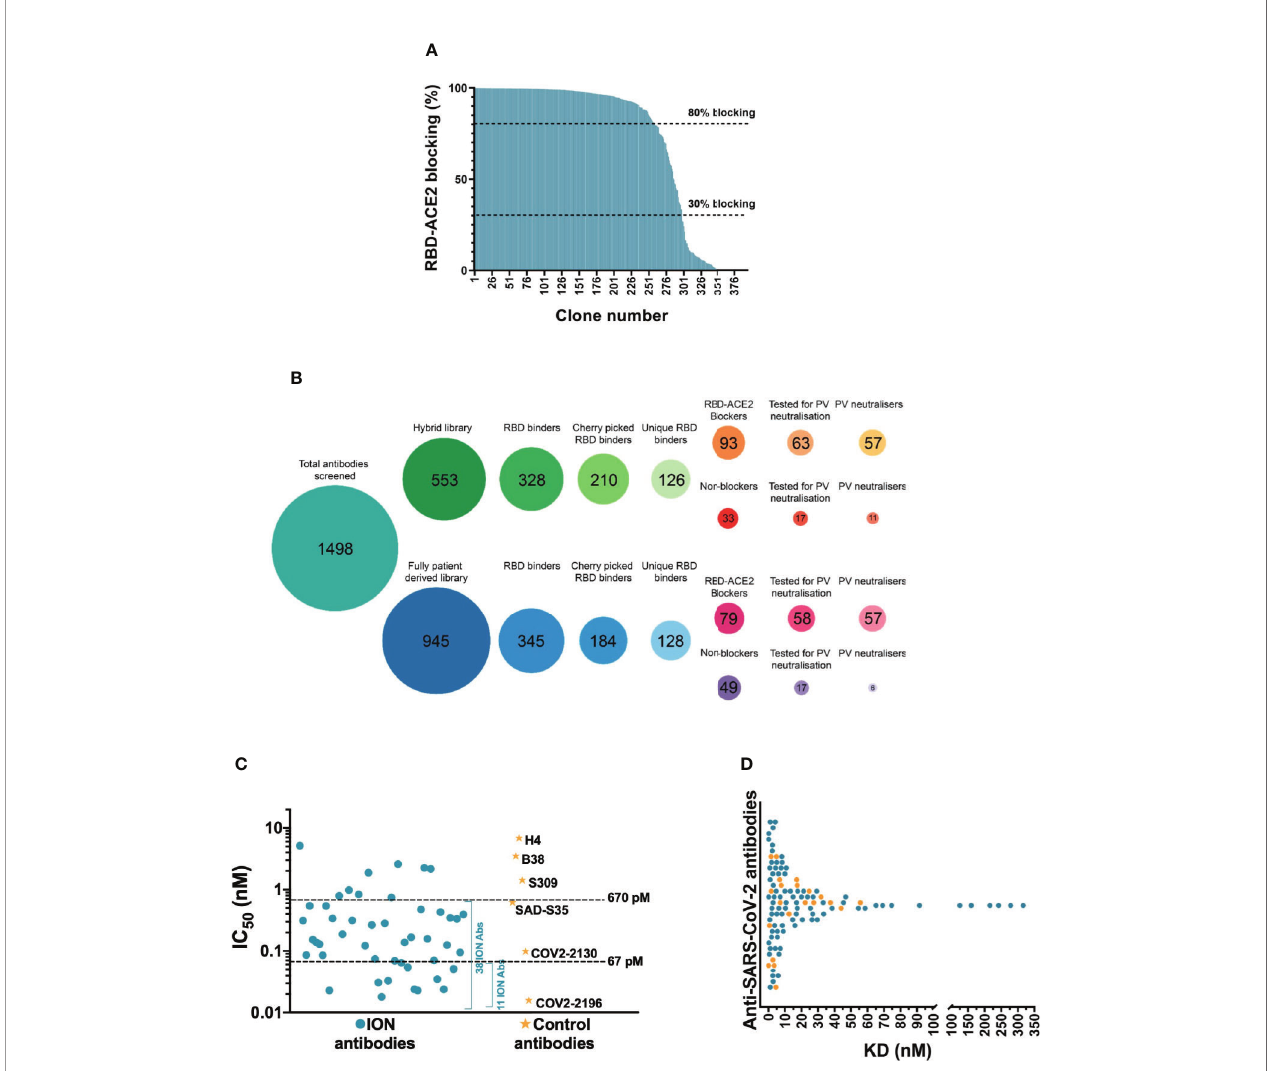
FIGURE 2 | Biochemical and functional characterization of SARS-CoV-2 antibodies. (A) Screening of SARS-CoV-2 binders for RBD-ACE2 blocking activity. Antibodies were tested and ranked in a biochemical blocking assay for their ability to block the RBD-ACE2 interaction. (B) Antibody screening process presented as bubble plots. The number of antibodies tested from the hybrid and fully patient derived libraries at various stages of the study is highlighted inside each bubble. Areas of bubbles are scaled relative to each other based on the number of antibodies that represent each bubble. (C) Pseudovirus neutralizing activity of 52 SARS- CoV-2 antibodies and control antibodies. (D) Dot plot representing the 1:1 RBD binding af fi nities of SARS-CoV-2 antibodies measured using SPR. The antibodies that are part of the fi nal panel of 21 are represented in orange dots. The break in the x-axis highlights the change in axis